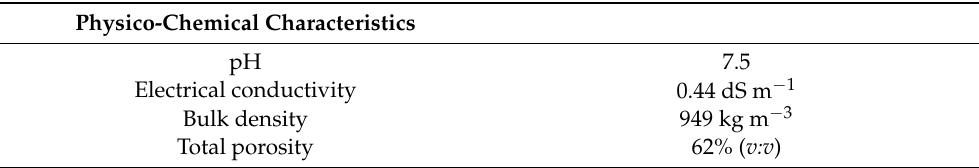
Table 6. Physico-chemical characteristics of potting substrate used for the rooting experiment. Physico-Chemical